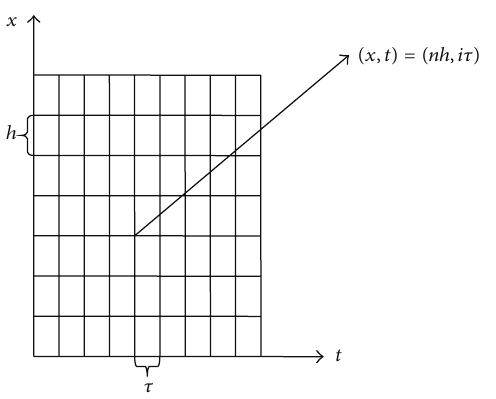
Figure 6: Sketch for difference